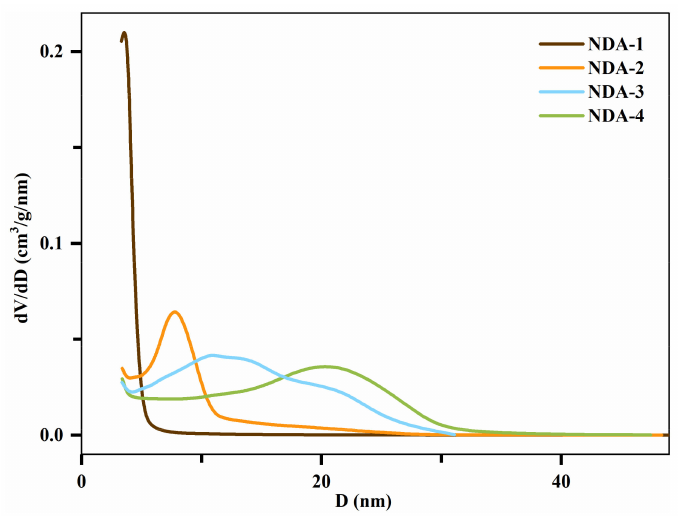
Figure 2. Mesopore diameter distribution of NDA-1, NDA-2, NDA-3, and NDA-4.